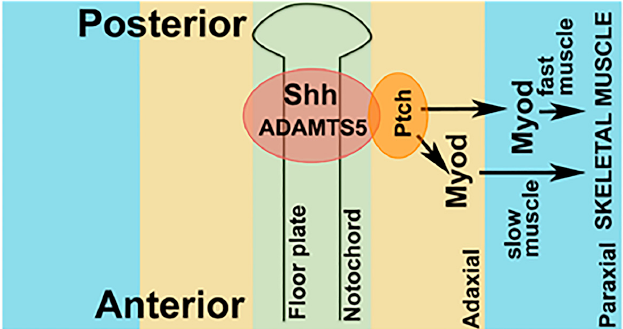
Figure 6. Model of interaction between Shh and ADAMTS5. Hypothetical model showing ADAMTS5 and Shh expression synergistically regulate downstream activation of MyoD in adaxial and paraxial mesoderm.